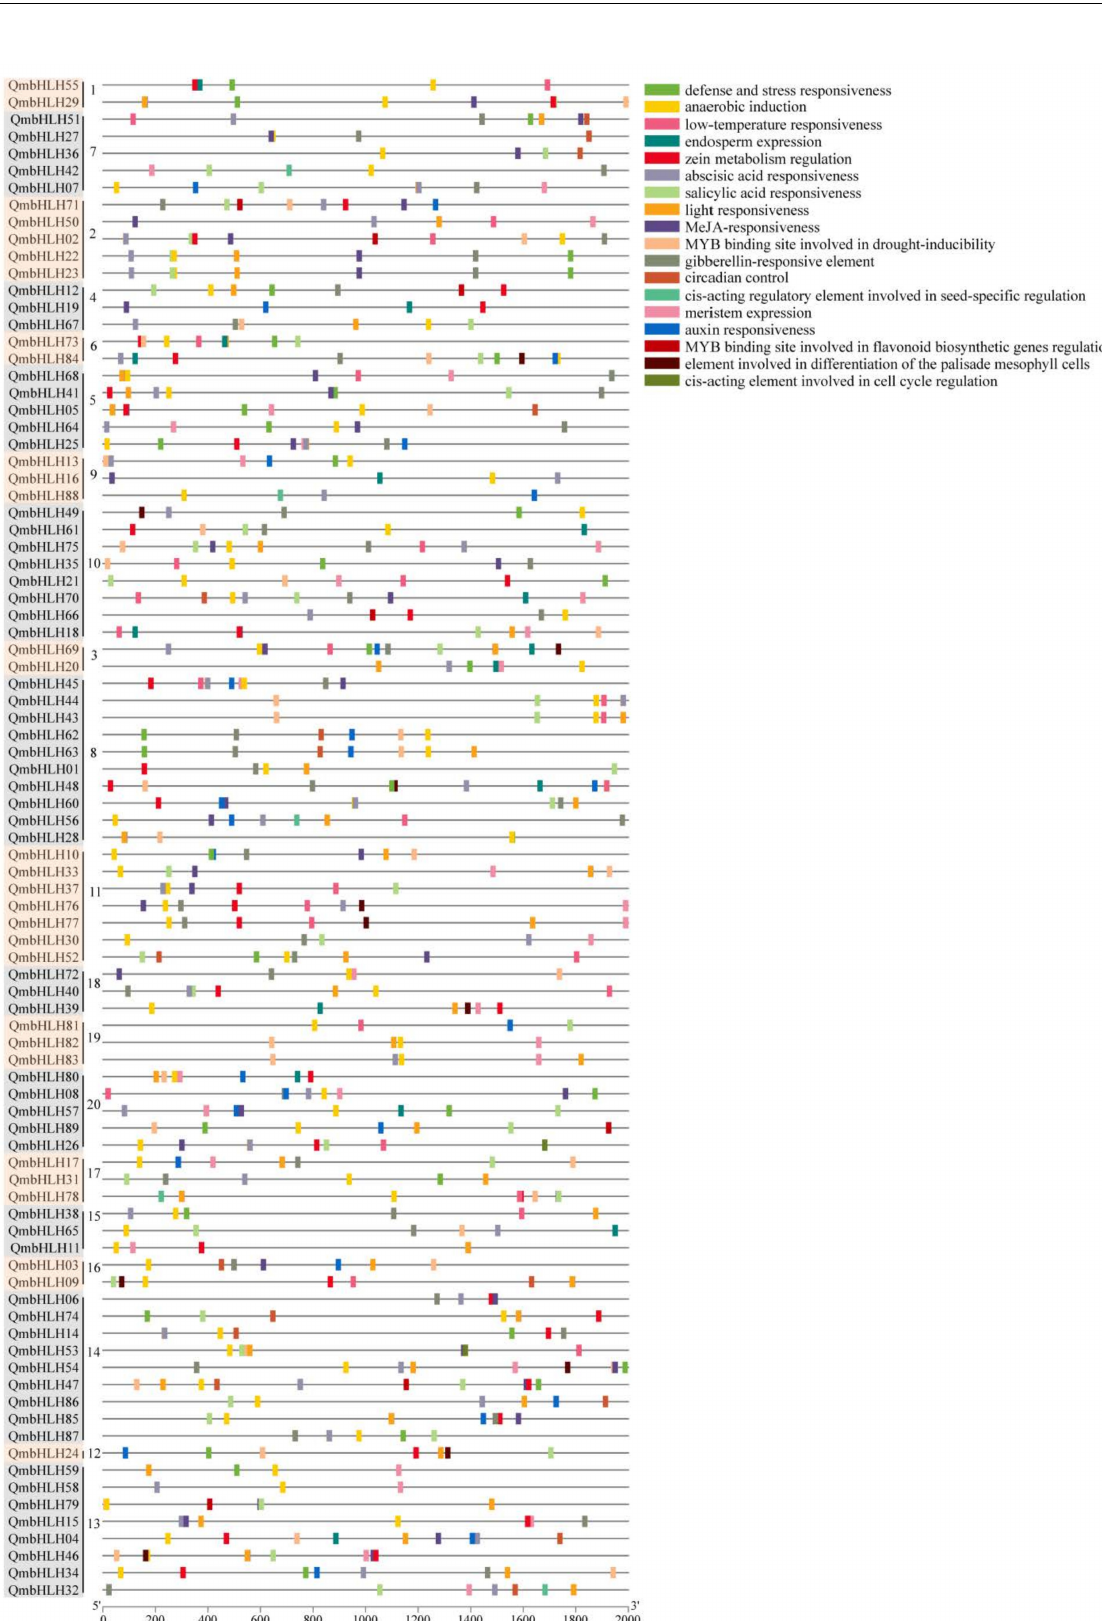
Figure 5. Cis-acting elements in the promoter region 2000 bp upstream of QmbHLH genes. Various colored rectangles denote distinct cis-acting elements; some elements are overlapping. The numbers 1–21 in the second column from the left indicates the QmbHLH genes were classified into 21 groups based on the clustering results of Figure